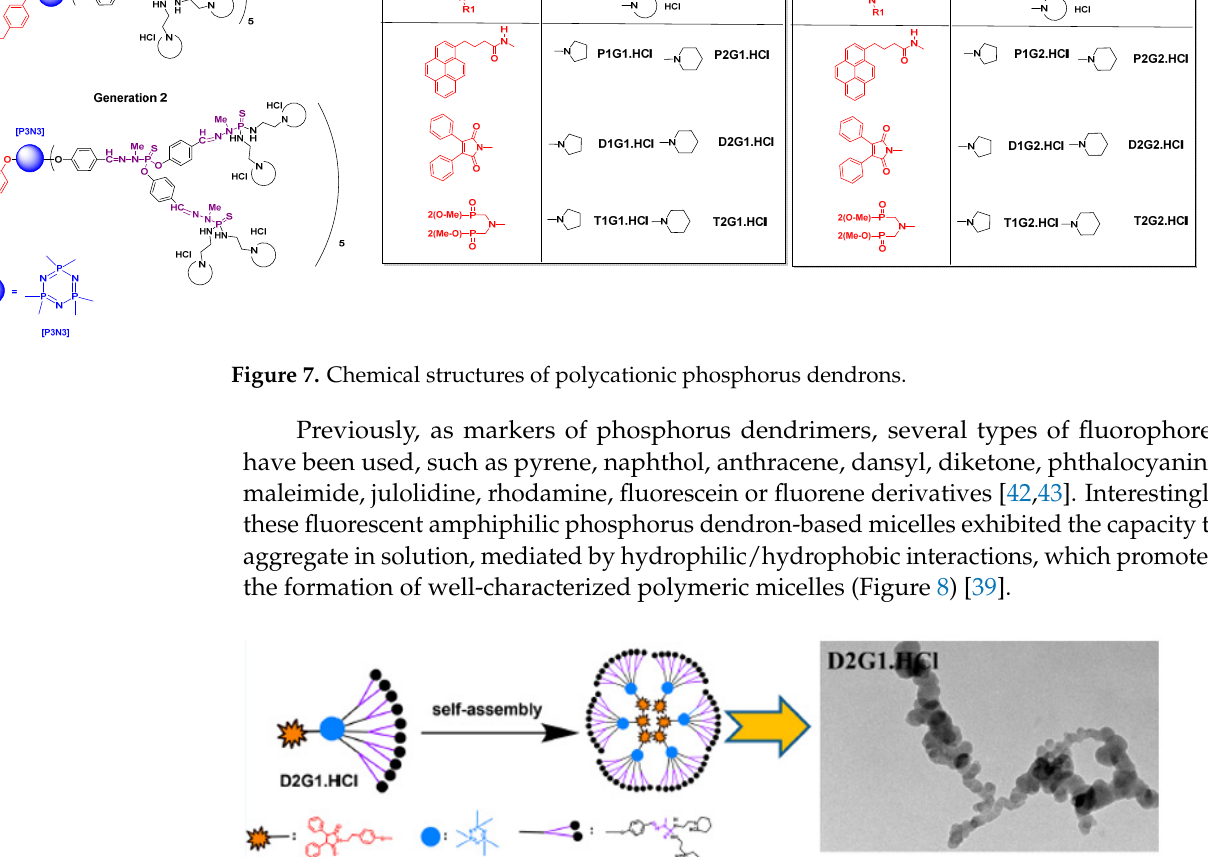
Table 2. CMC (µM) of amphiphilic phosphorus dendrons in water.